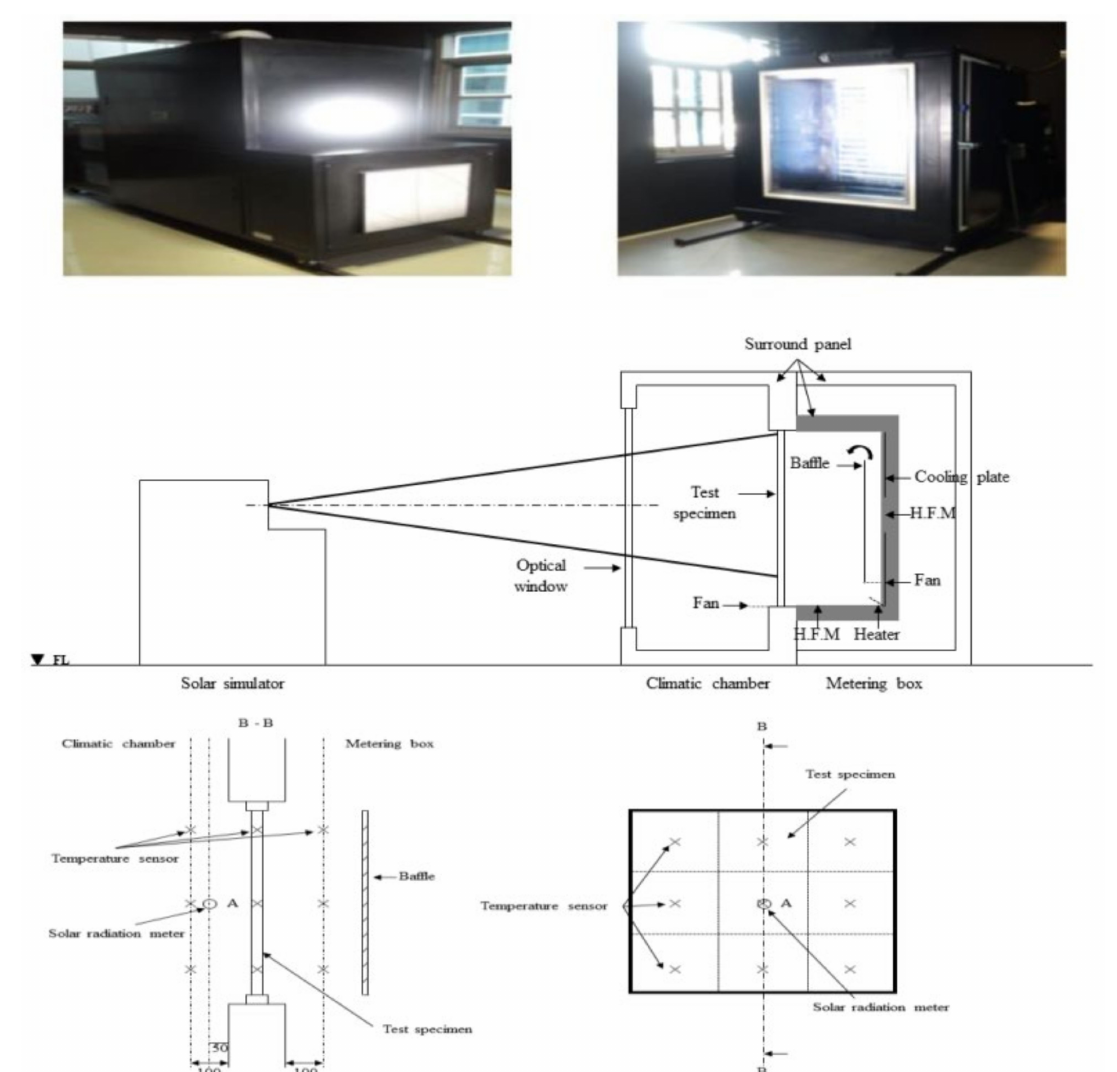
Figure 6. Test device configuration and measurement instruments.